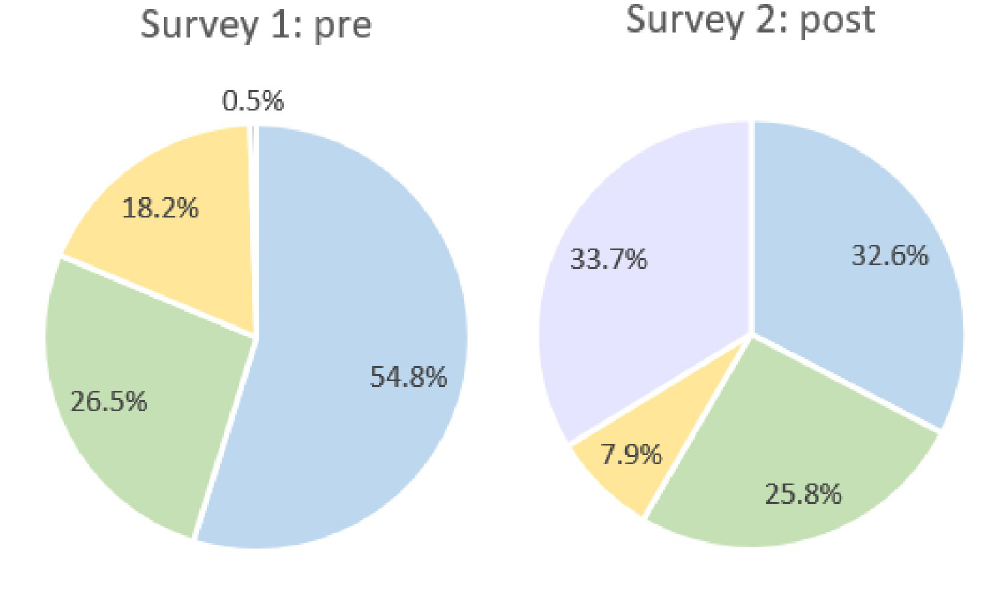
Fig 2. Participant area of work